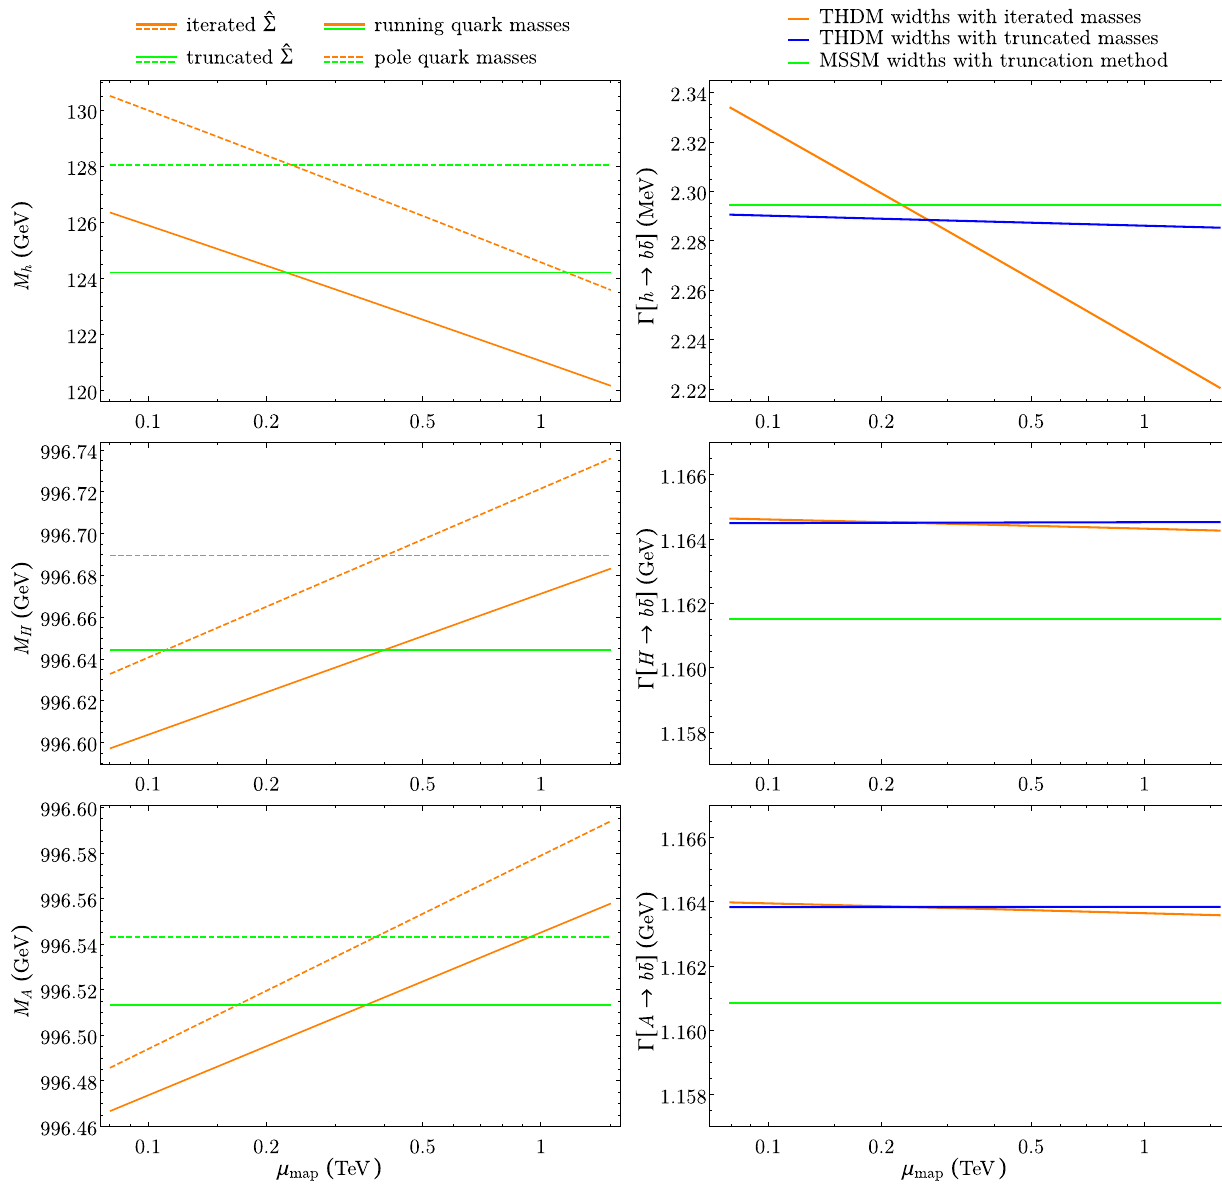
expansionofEq.(4).Thegreencurvesdisplaythe ξ -independentwidths in the MSSM, i.e. with an evaluation of the decay amplitude at the tree- level Higgs masses (‘truncation’); the other curves are obtained in the THDM framework (‘matching’), i.e. they are free of gauge-violating terms by construction. The blue curves are derived using the ‘trun- cated’ Higgs masses of the MSSM (with Eq.(4)) as matching input. They illustrate the (small) explicit scale dependence of the widths. The (cid:19) (cid:20) α α orange curves characterize the parametric dependence, originating in q s the mass determination via a pole search in a THDM framework (‘map- ping’), when the latter is chosen as input instead. The quark masses are set to running masses at the scale of the decaying